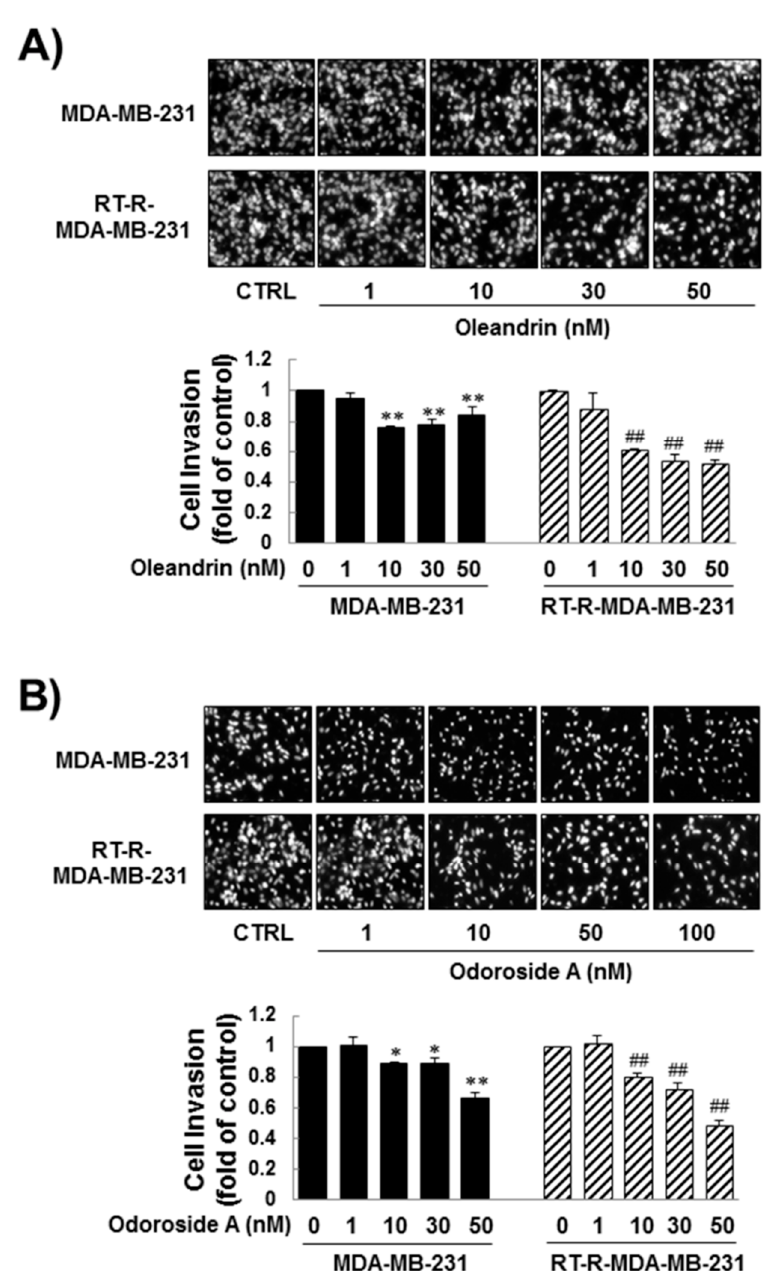
Figure 3. Inhibitory effect of oleandrin and odoroside A on the invasion of MDA-MB-231 and RT-MDA-MB-231 cells. MDA-MB-231 and RT-MDA-MB-231 cells were treated with oleandrin ( A ) and odoroside A ( B ) at the indicated concentrations for 24 h, and then the cells were collected, added to ECs-Matrigel-coated insert wells and incubated overnight (for 16 h) at 37 °C. The cells that had invaded across the membrane were stained with 4’,6-diamidino-2-phenylindole (DAPI) and counted under a fluorescence microscope (×200). The values are expressed as the means ± SEM from three independent determinations. * p < 0.05, ** p < 0.01 compared with the control group of MDA-MB-231 cells; ## p < 0.01 compared with the control group of RT-R-MDA-MB-231 cells.